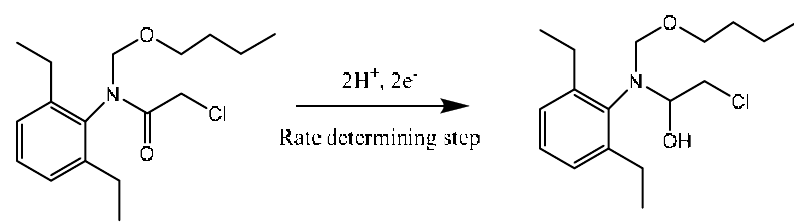
Fig.8. Schematic representation of possible electrochemical reduction mechanism of butachlor on Pd@MWCNTs/GCE